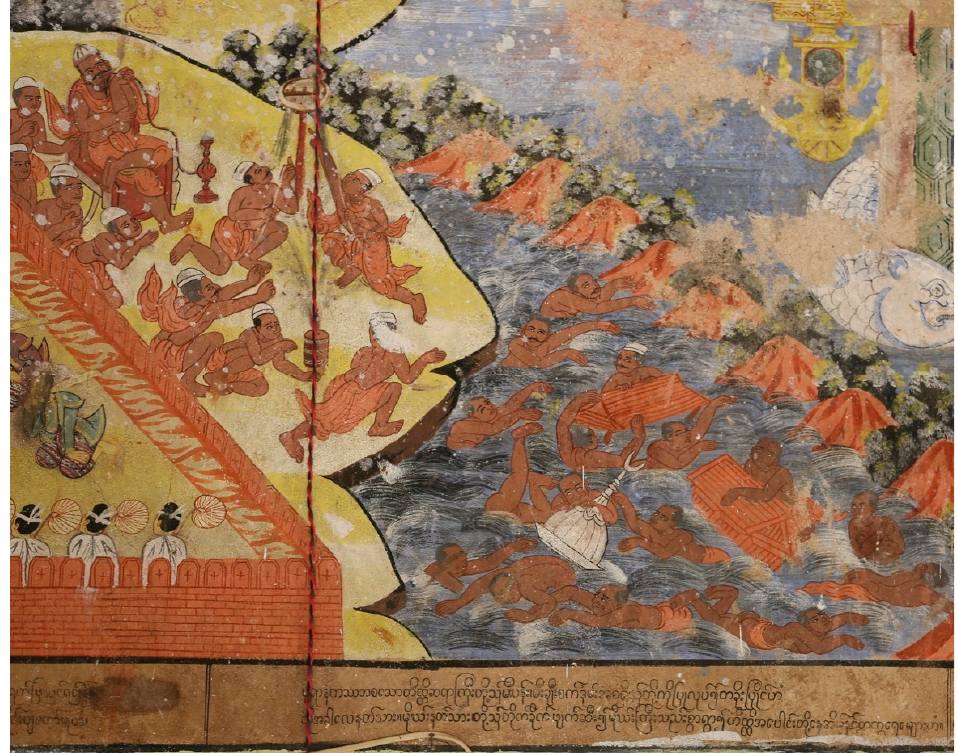
Figure 8. Pakokku, Shwetantit, 1917. Defeat of heretics identified here as Muslims, pointlessly clutching a mosque roof—recognizable by the crescent moon. They are drowning in the ocean surrounding Meru, hinted at by the giant fish encircling the mountain.